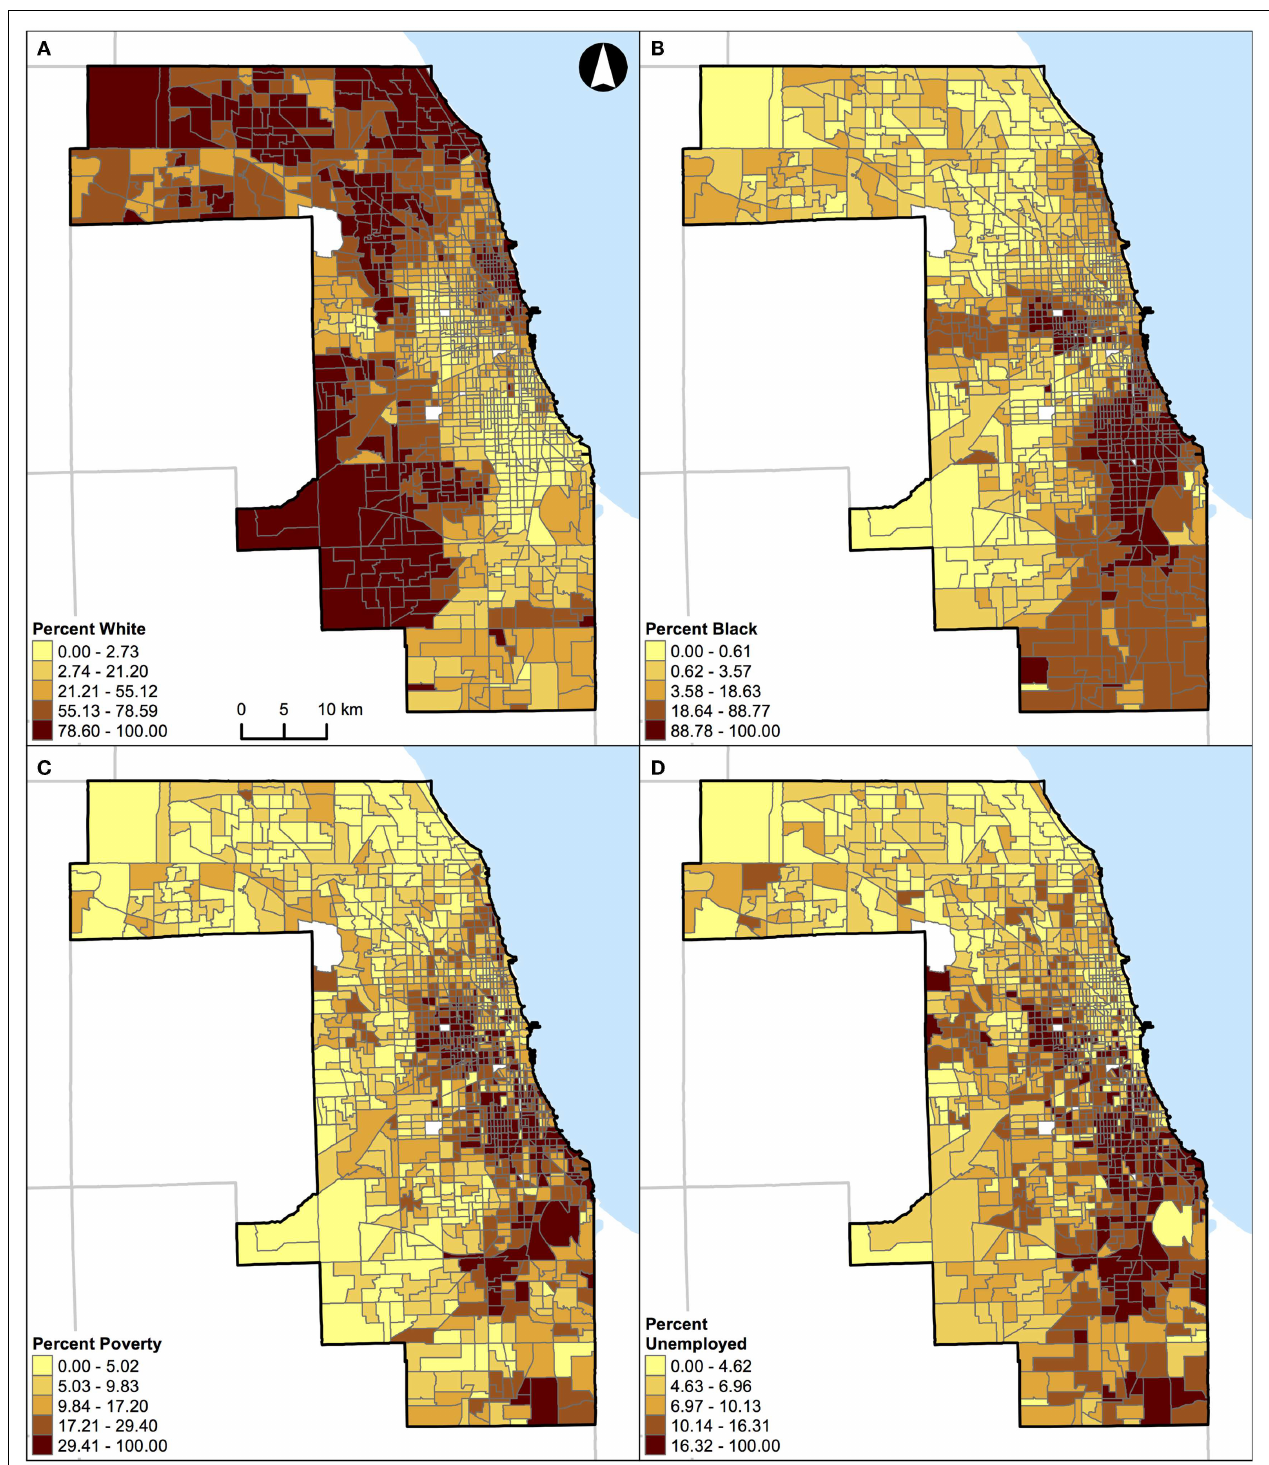
FIGURE 9 | Geographic distribution of population characteristics expressed as percentages in Chicago, IL, USA (1,327 census tracts) . (A) Percent white, (B) percent black, (C) percent Hispanic, and (D) percent other racial/ethnic groups. A quantile classification scheme was used to display the percentages.